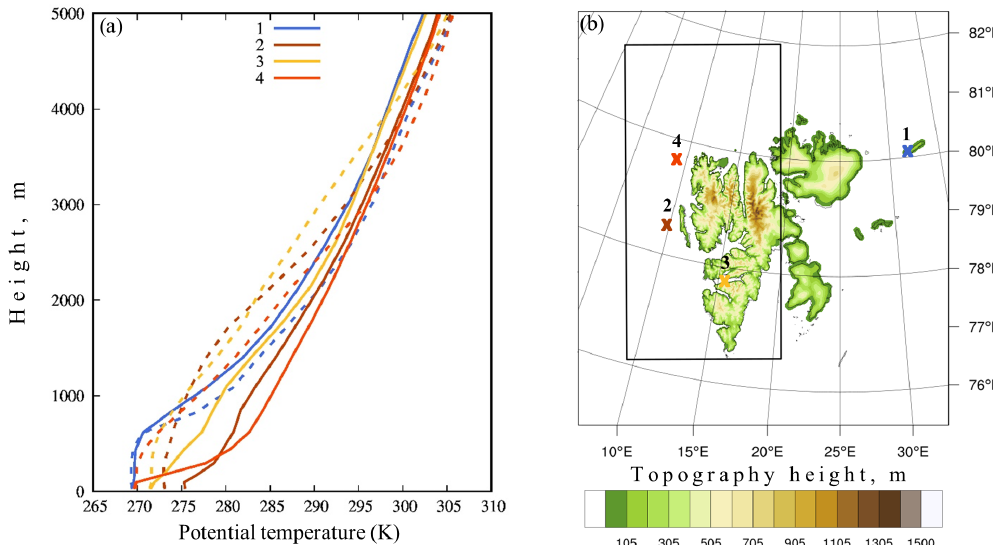
Figure 7. (a) Vertical profiles of potential temperature in points 1–4 upstream and downstream of Svalbard at the beginning (06:00UTC, 30 May 2017, dashed lines) and in the middle of the foehn episode (06:00UTC, 31 May 2017, solid lines) according to modeling results and (b) map of nested model domains 2 and 3 showing the locations of points 1–4 (X marks) and topography height (color).